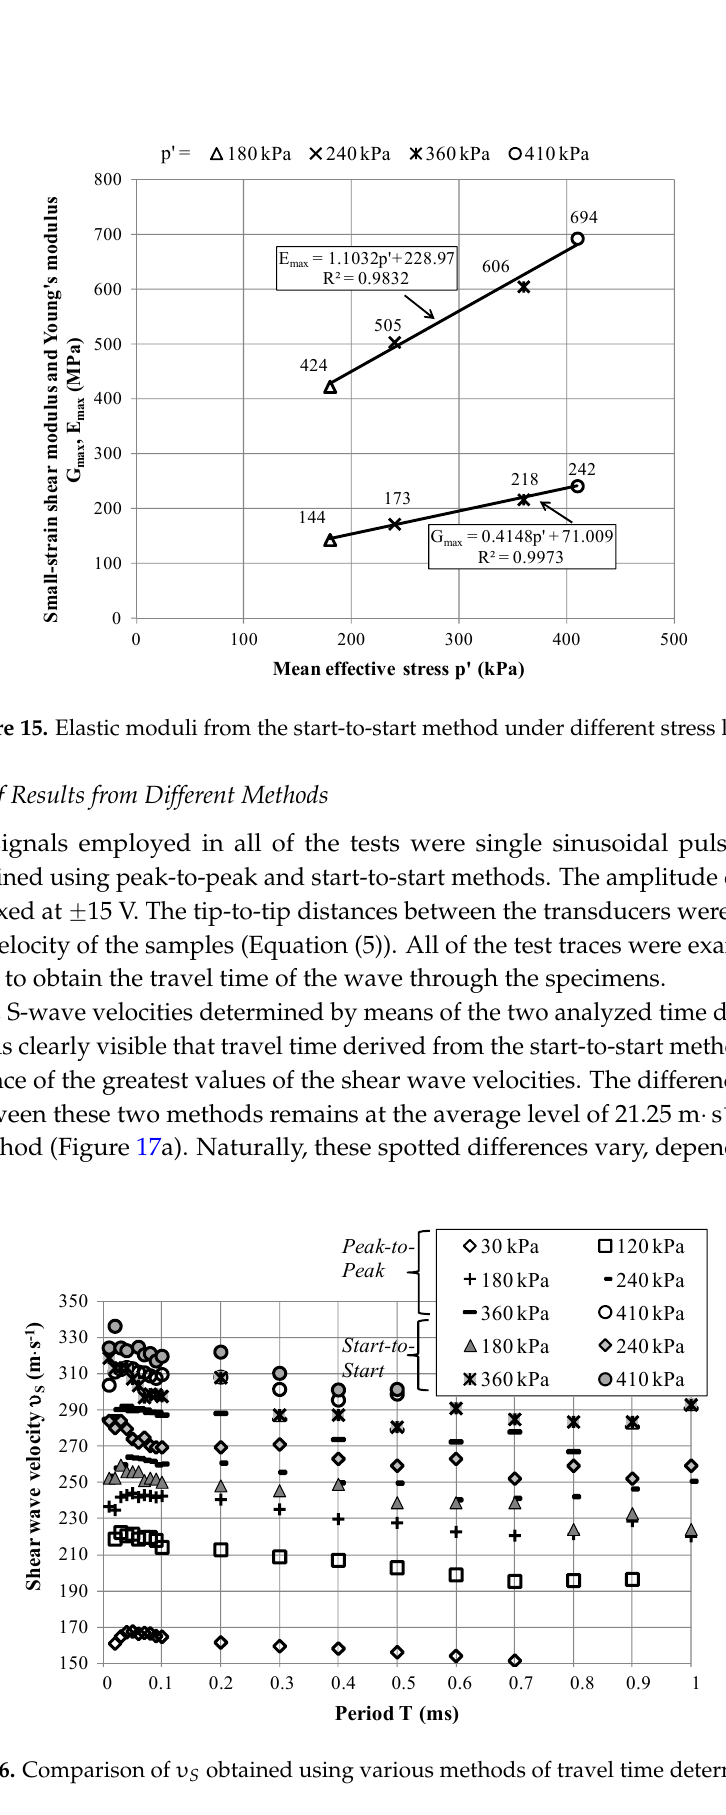
Figure 16. Comparison of υ S obtained using various methods of travel time determination.